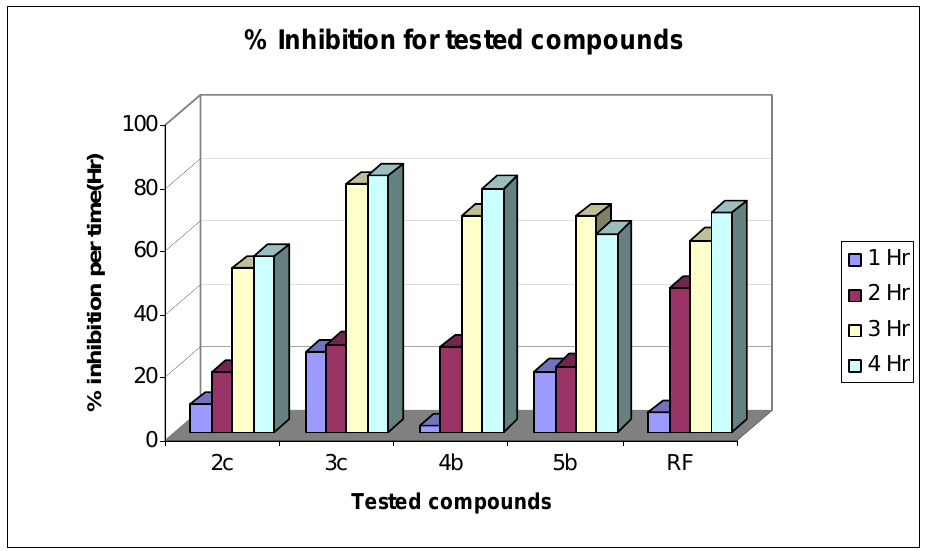
Figure 1 . Anti-inflammatory test